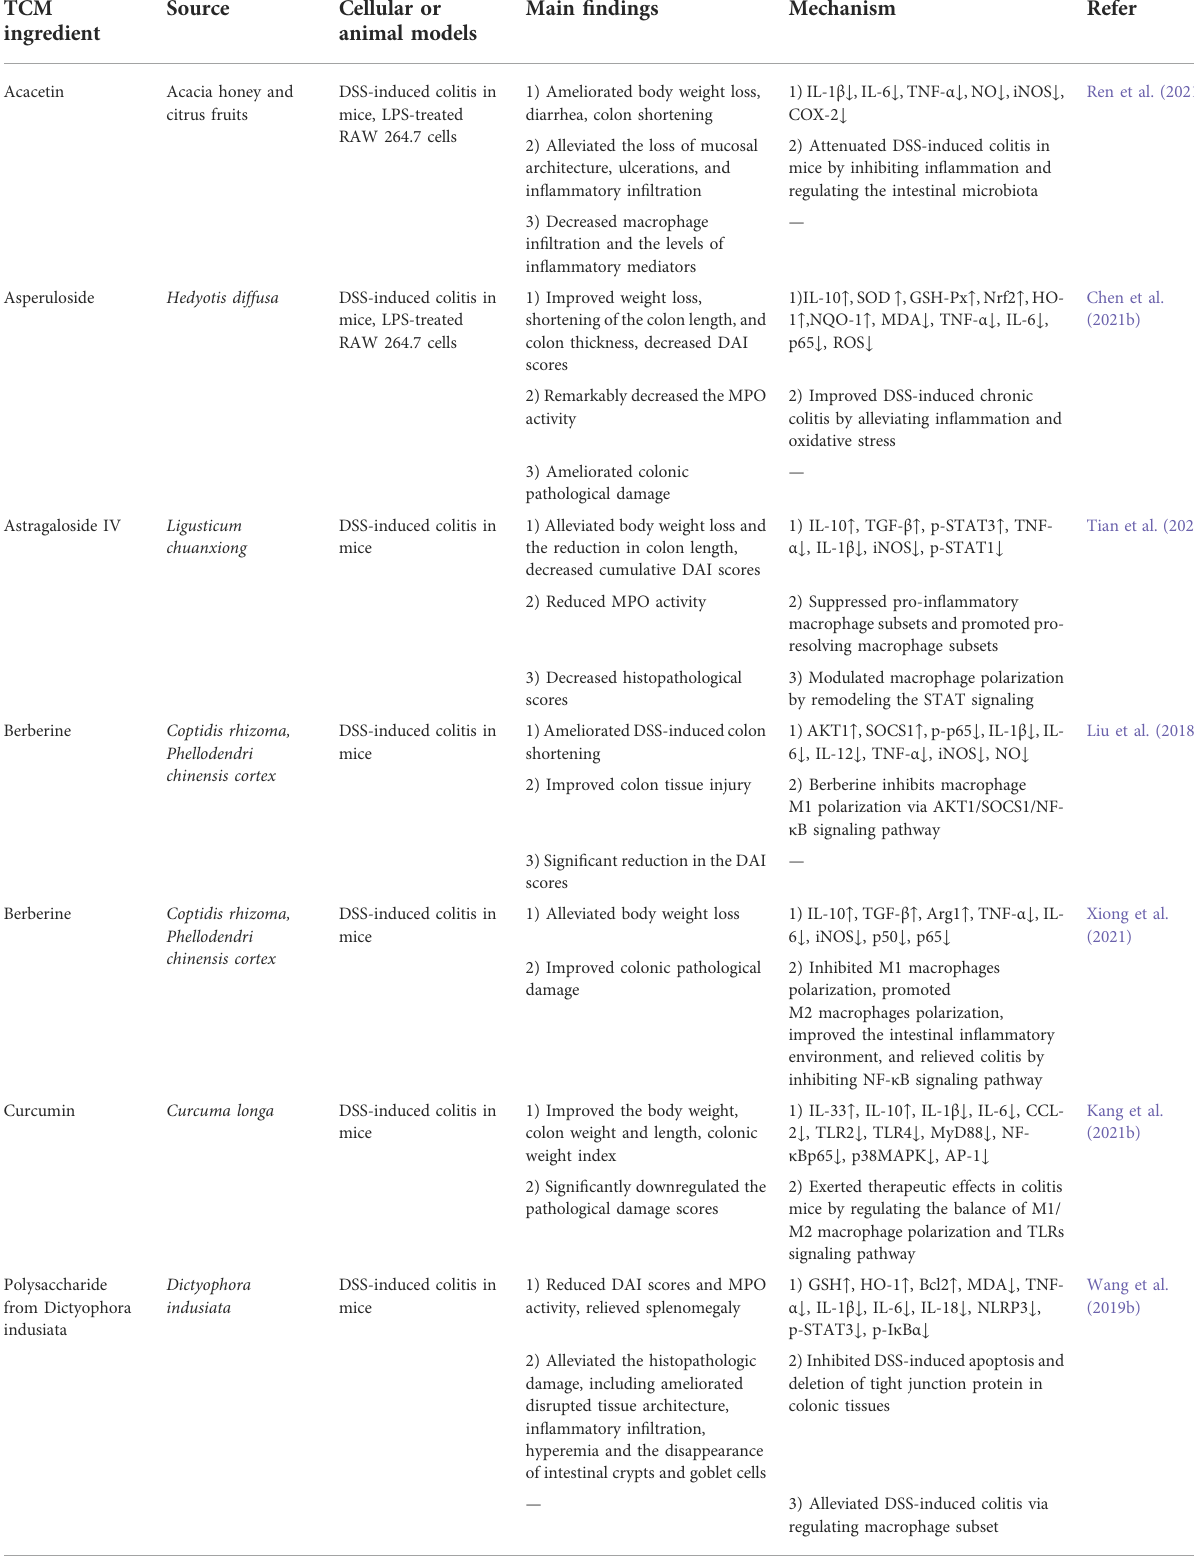
TABLE 2 TCM ingredient alleviates UC by regulating macrophage